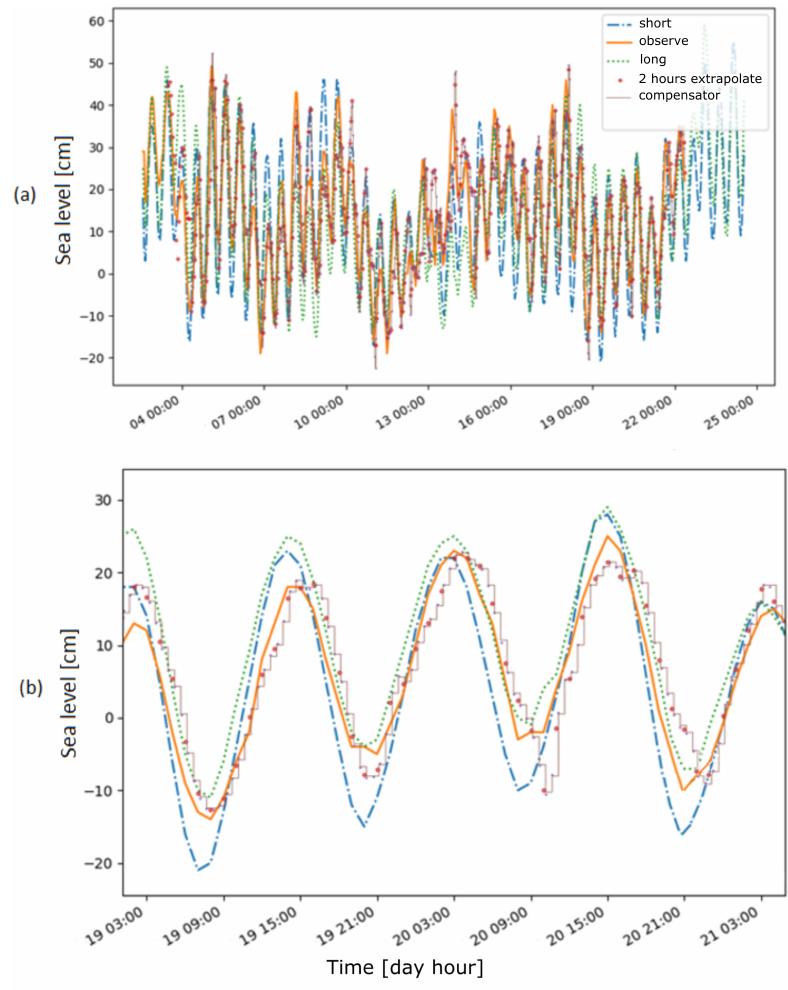
Figure 11. ( a ) Two-hour prediction from the observational data compared to long- and short-forecast data in October 2018 (available from SMHI). ( b ) A zoom in of two days of data.